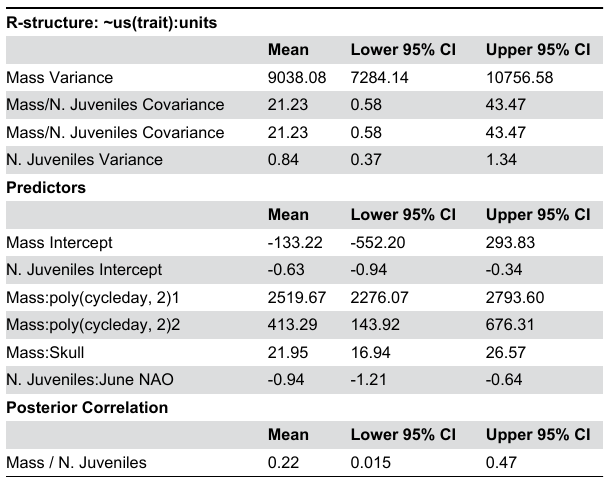
File S1. Online Supporting Information. Figure S1. Body mass variation by year for light-bellied Brent geese calculated using 6 years of data. Figure S2. Temporal variation in June NAO from a 60 year dataset. Code S1. R code for Bayesian Hierarchical models used for prediction. Code S2 R code for multivariate response model used to validate the derived variable